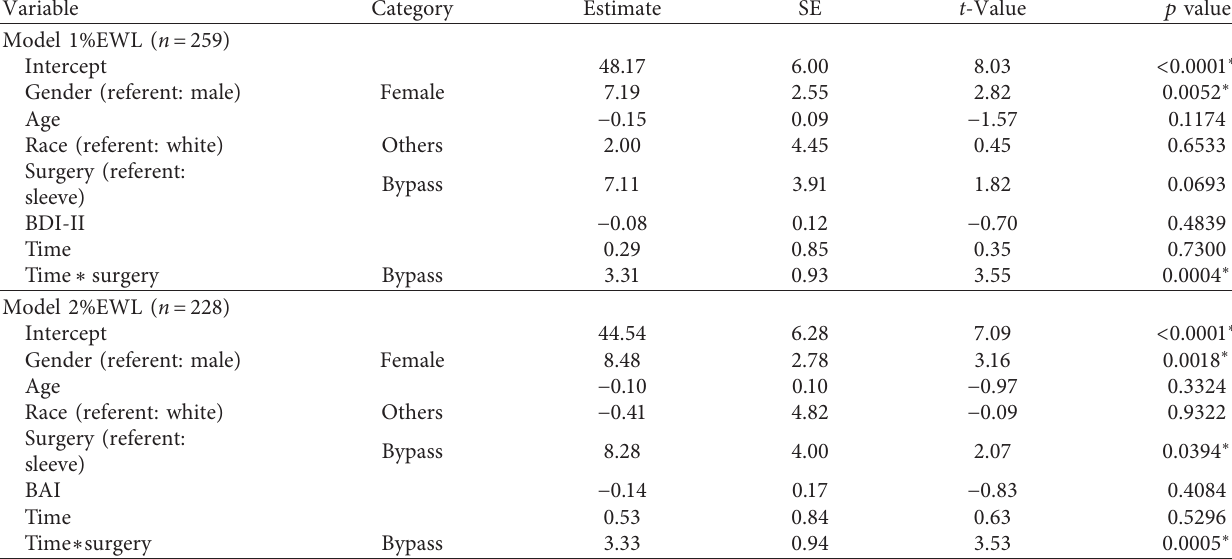
Table 2: Mixed regression models for percent of excess body weight